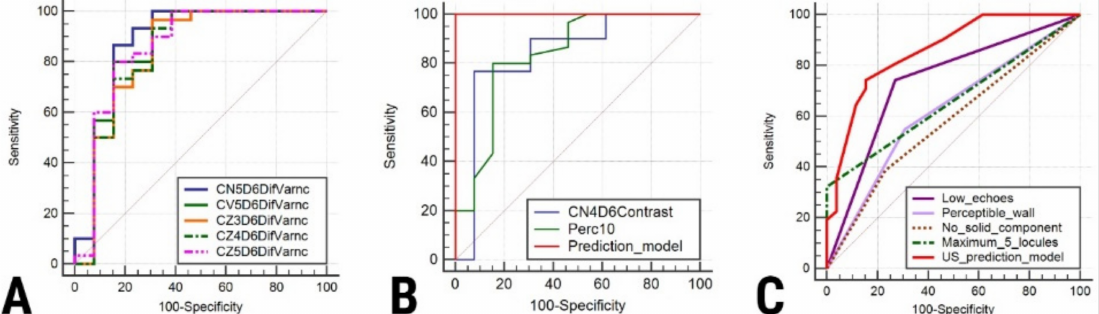
Figure 3. Comparison of areas under the curve for the differentiation of endometriomas from hemorrhagic cysts based on ( A ) the difference of variance parameters, ( B ) contrast and percentile parameters and the prediction model composed of independent texture parameters, and ( C ) classic ultrasound features of endometriomas and their combined diagnostic